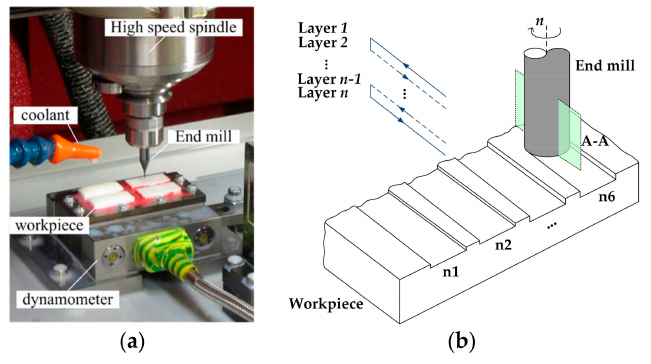
Figure 3. View of ( a ) experimental set-up and ( b ) groove milling sketch. Table 3. The experimental matrix of cutting